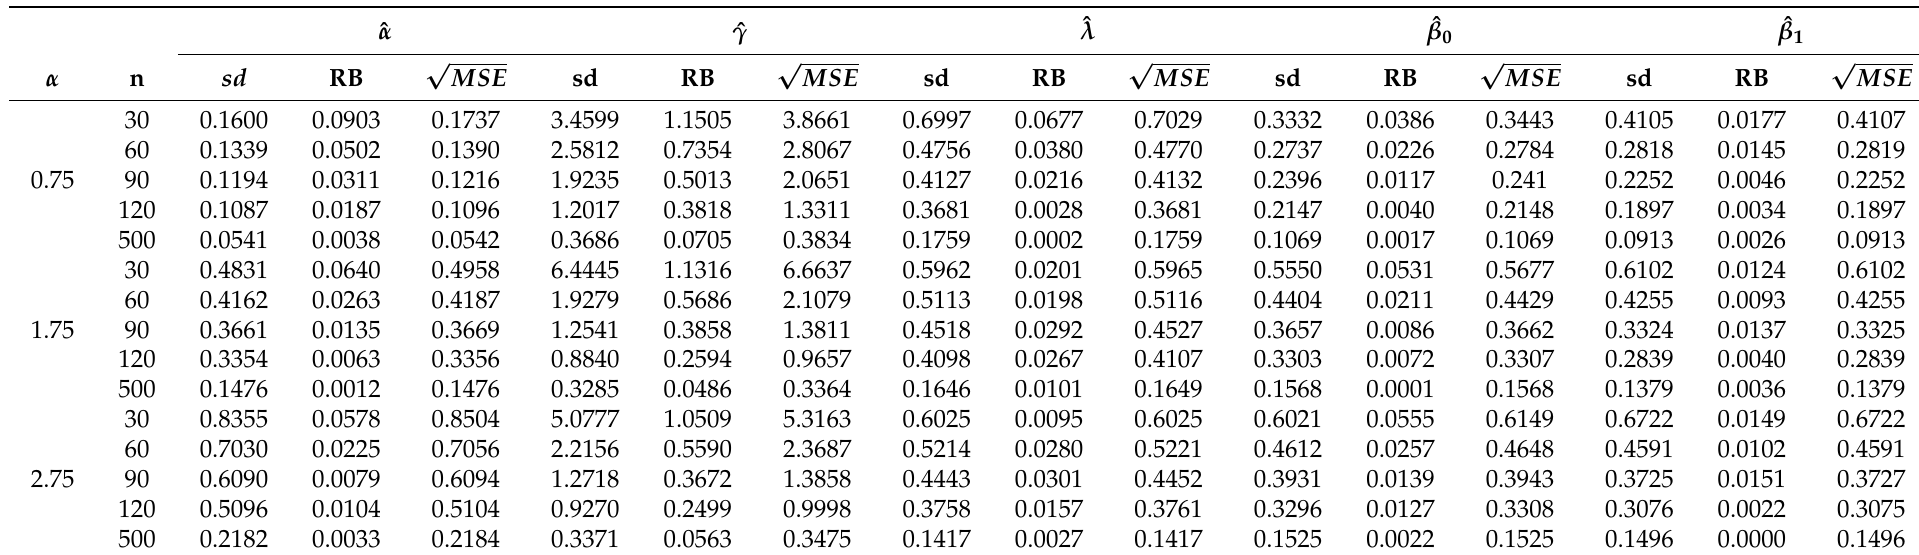
√ MSE for the EGSHN ( α ,2.25,0.75,1.5,1 )